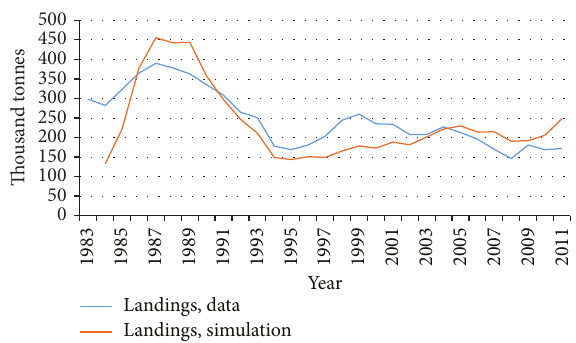
Figure 5: Comparison of output from model simulations and actual stock assessment data for fishable biomass.